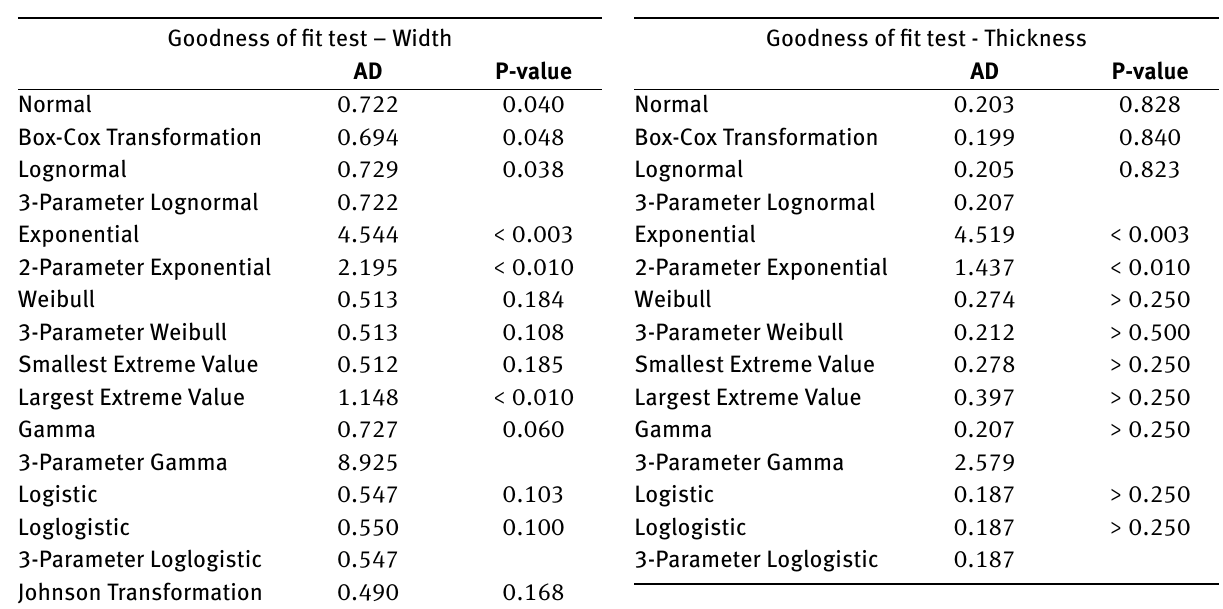
Table 3: Individual distribution identification for the width of speci- mens.